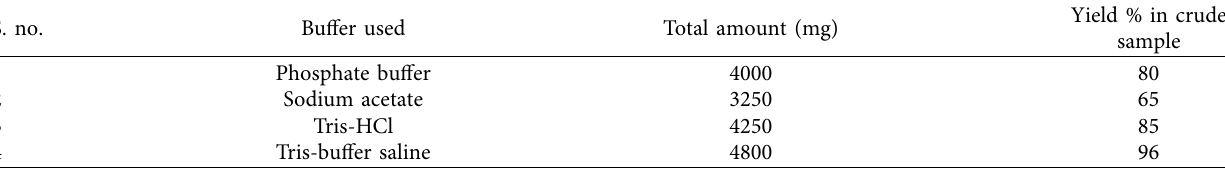
Table 1: Percentage of protein yield obtained through diferent extraction